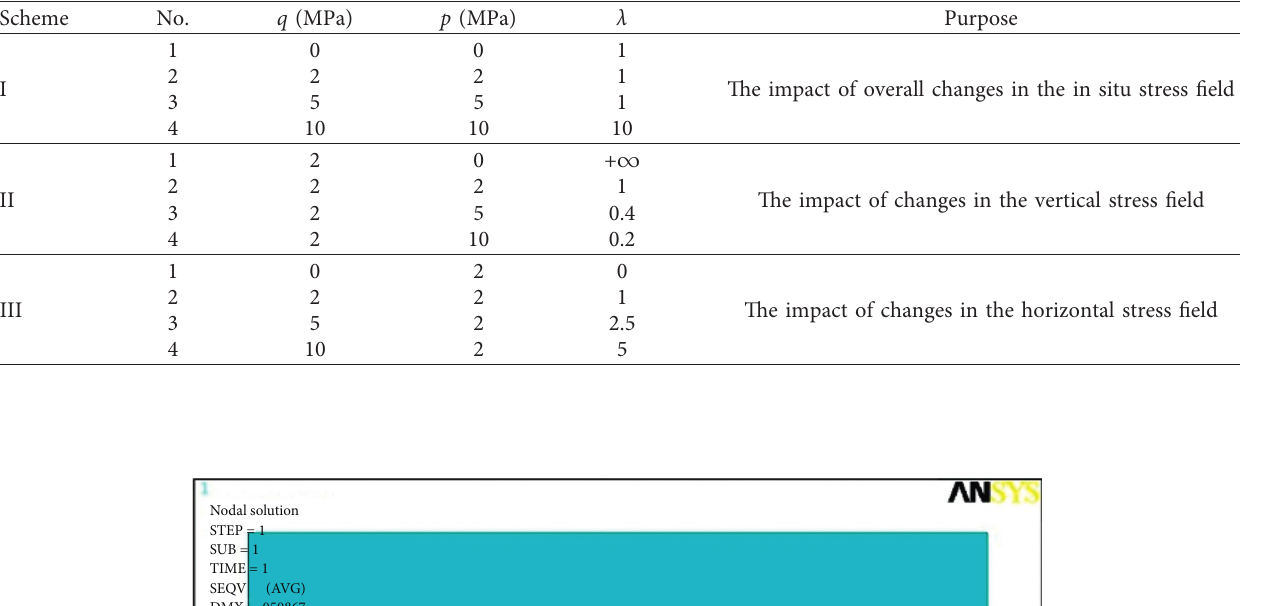
Table 3: Comparison of different schemes and parameter setting.